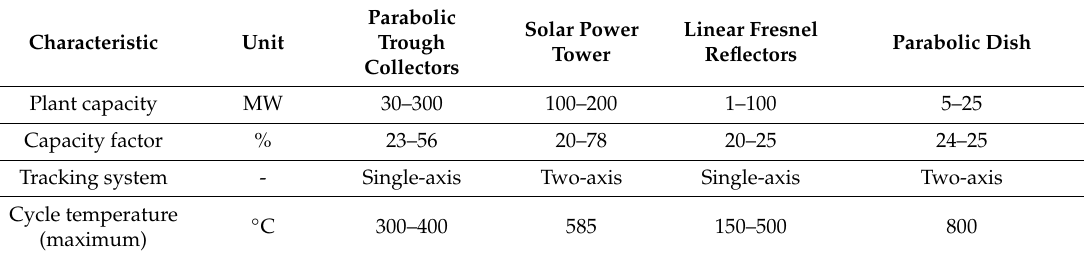
Figure 3. A schematic diagram of a parabolic trough (PT) system. Table 2. Characteristics of CSP technologies [10,17,18,21–24].